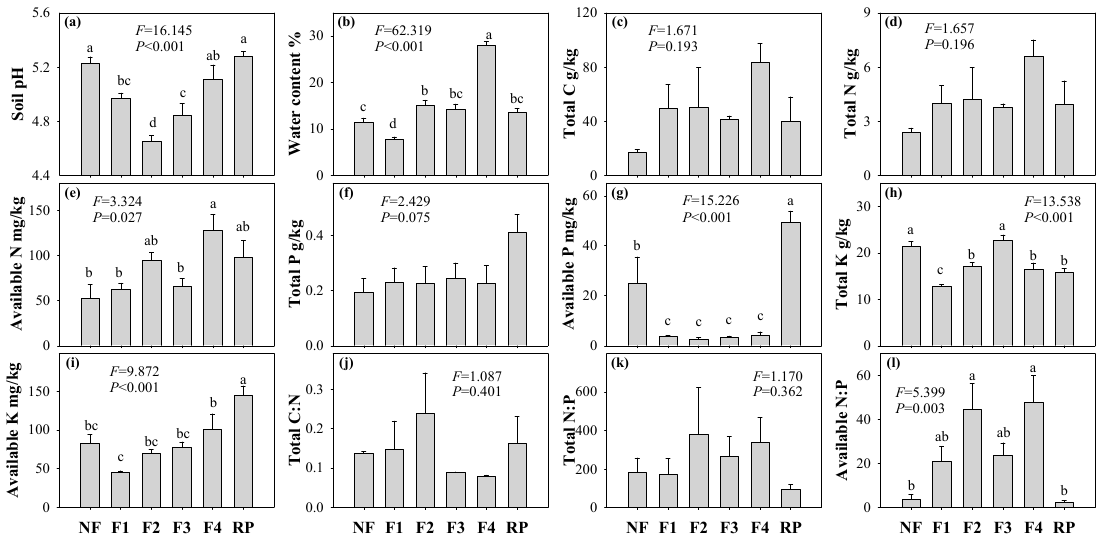
Figure 1. Soil properties of different forests. ( a ) Soil pH, ( b ) water content, ( c ) total C, ( d ) total N, ( e ) available N, ( f ) total P, ( g ) available P, ( h ) total K, ( i ) available K, ( j ) total C:N, ( k ) total N:P and ( l ) available N:P. Statistically significant differences ( P < 0.05) are denoted by different letters (NF: Nonforest, F1: Pinus densiflora forest, F2: Pinus densiflora + Quercus acutissima mixed forest, F3: Quercus acutissima forest, F4: Deciduous broadleaved mixed forest, and RP: Robinia pseudoacacia plantation).